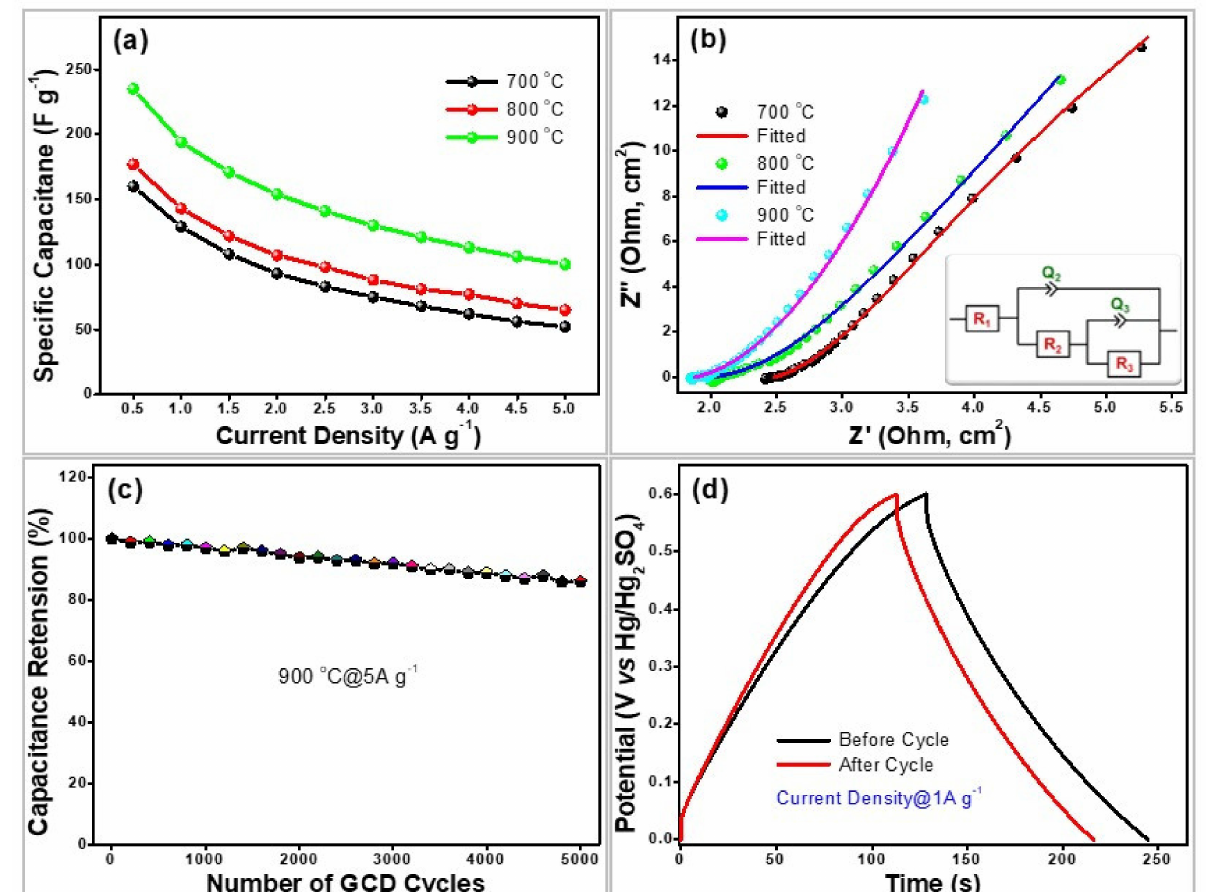
Figure 8. ( a ) Specific capacitance of NRPCs, ( b ) EIS showing Nyquist plots of NRPCs ( c ) Long-term cycling stability of NRPC-900 at a current density of 5 A g − 1 and ( d ) GCD curves of NRPC-900 before and after 5000 cycles at a current density of 1 A g − 1